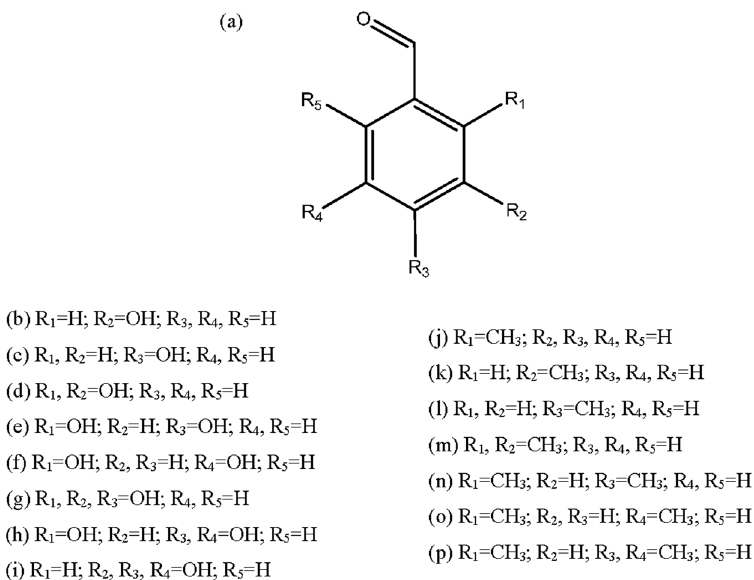
Figure 1. Structures of hydroxybenzaldehyde and methylbenzaldehyde analogues. ( a ) Benzaldehyde; ( b ) 3-hydroxybenzaldehyde; ( c ) 4-hydroxybenzaldehyde; ( d ) 2,3-dihydroxybenzladehyde; ( e ) 2,4-dihydroxybenzladehyde; ( f ) 2,5-dihydroxybenzladehyde; ( g ) 2,3,4-trihydroxybenzladehyde; ( h ) 2,4,5-trihydroxybenzladehyde; ( i ) 3,4,5-trihydroxybenzladehyde; ( j ) 2-methylbenzaldehyde; ( k ) 3-methylbenzaldehyde; ( l ) 4-methylbenzaldehyde; ( m ) 2,3-dimethylbenzladehyde; ( n ) 2,4-dimethylbenzladehyde; ( o ) 2,5-dimethylbenzladehyde; ( p )